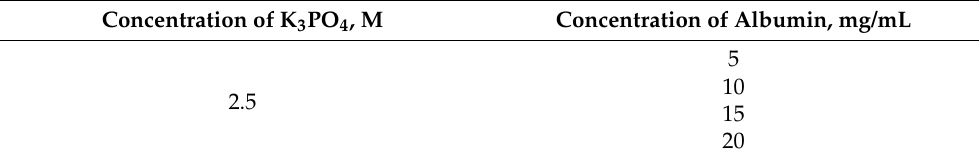
Table 2. Concentrations of the solutions used for preparation of protein